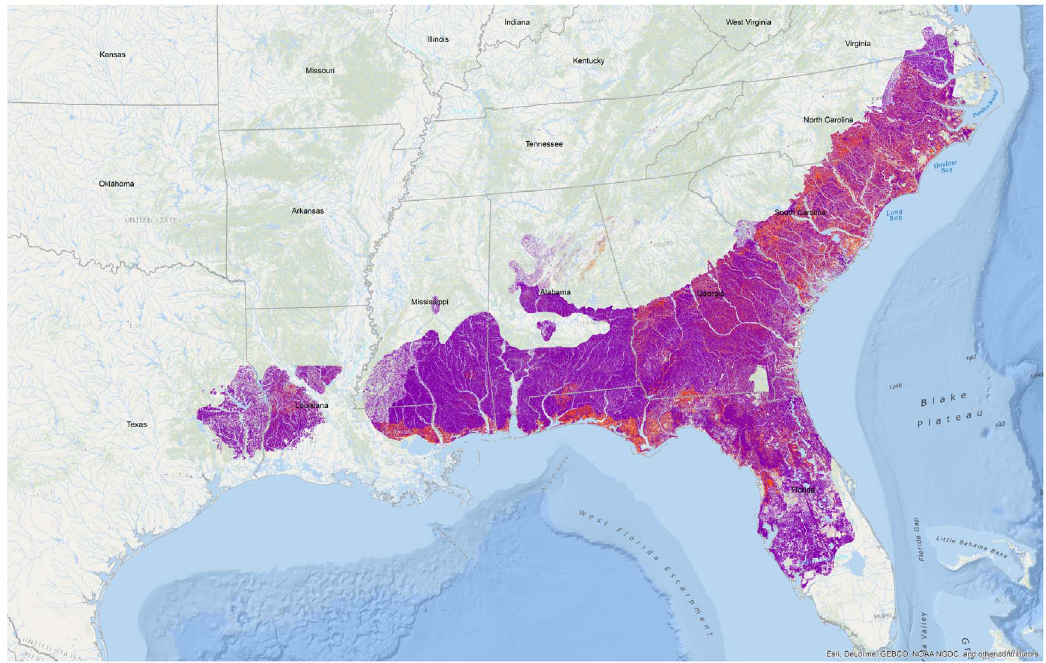
Figure 2. Historic (purple) and current (red) longleaf pine habitat in the southeastern US. GIS data provided by NatureServe and LandScope America.